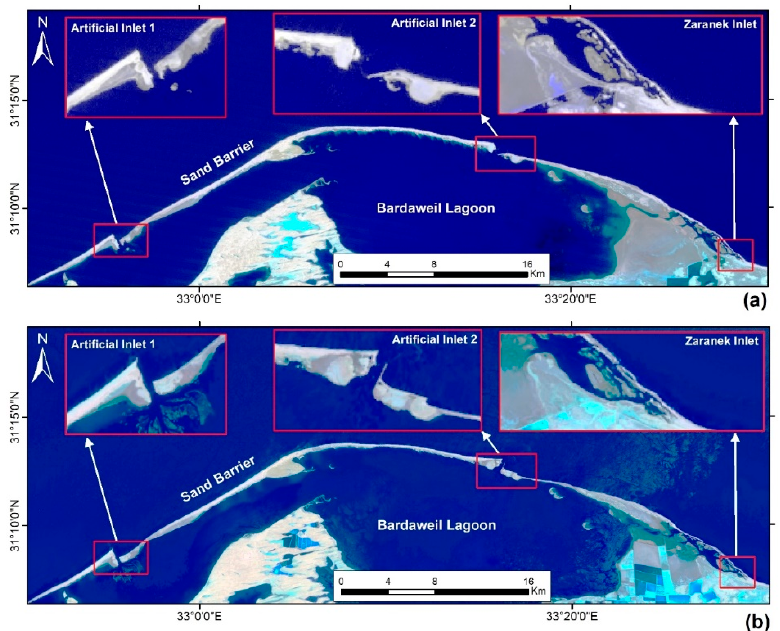
Figure 12. The Bardaweil Lagoon Barrier Coast ( a ) 1990 Landsat-TM ( b ) 2020 Landsat-OLI TIRS.